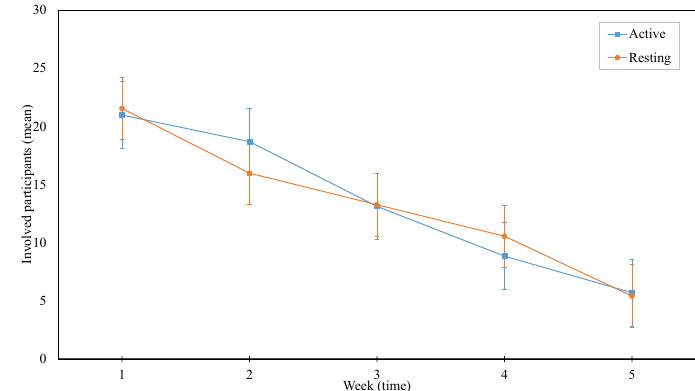
Figure 5. Comparison of participation in each treatment